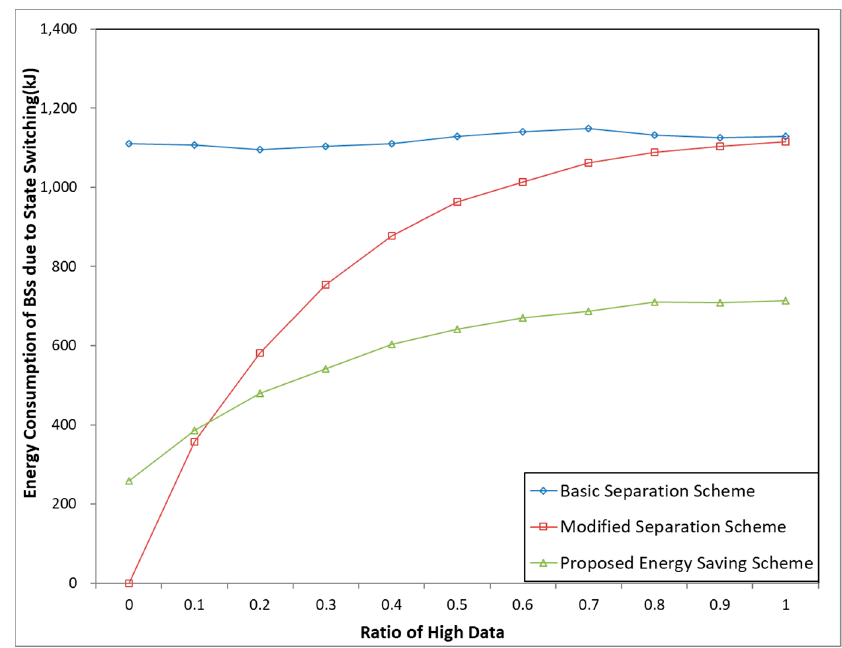
Figure 13. Energy consumption of BSs due to traffic processing.